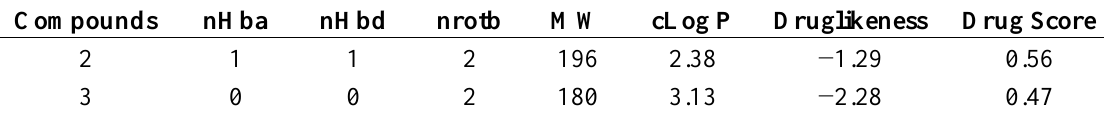
Table 1. Pharmacokinetic parameters (Catalyst, Chemaxon and Osiris